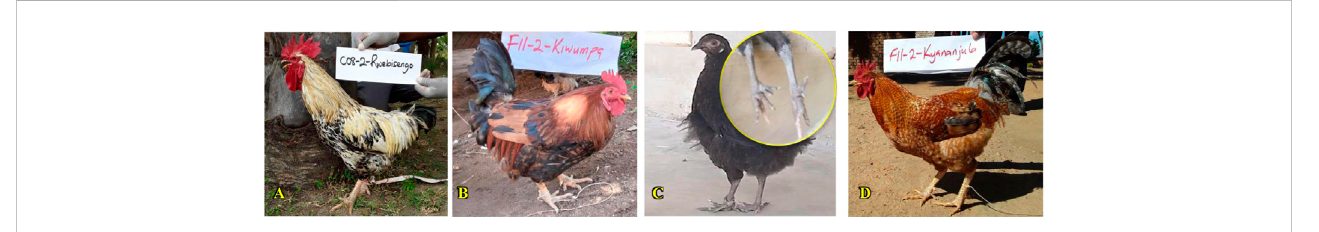
FIGURE 7 Skeletal variance. (A) Rumpless. (B) Dwarf. (C) Polydactyl. (D) Normal skeletal